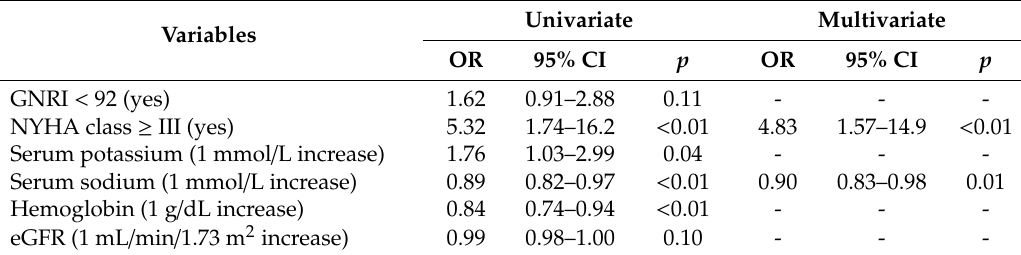
Table 3. Univariate and multivariate analyses of factors associated with length of hospital stay in HFrEF. Univariate Multivariate Variables OR 95% CI OR